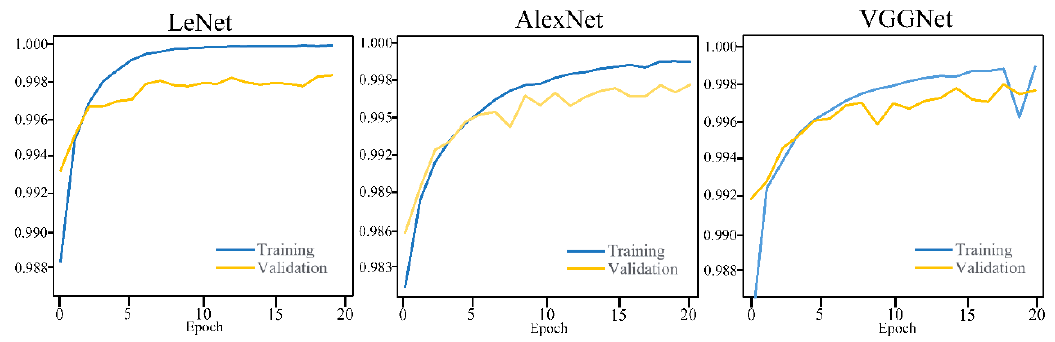
Figure 10. Loss of models. Blue lines represent the loss on training set, orange lines represent the loss on validation set.